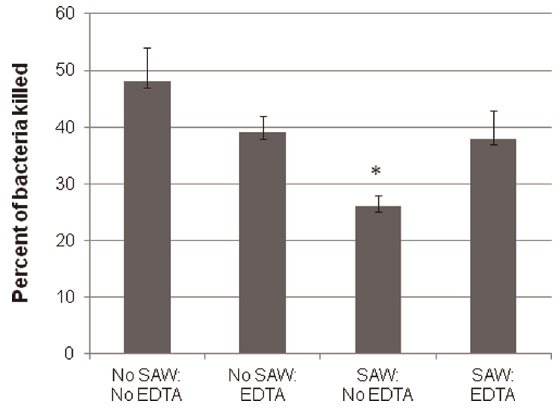
Figure 4. The effects of EDTA on neutrophil mediated killing of bacteria in fibrin gels. Bacterial killing was done by co-embedding human neutrophils (10 5 cells/gel) with 10 5 CFU S. epidermidis in the presence or absence of 5 mM EDTA and incubated at 37 u C for 90 mins. The gels were then lysed and bacteria counted as described under Materials and Methods. Shown is the percent 6 SEM of S. epidermidis killed by neutrophils in a representative experiment (n=3).